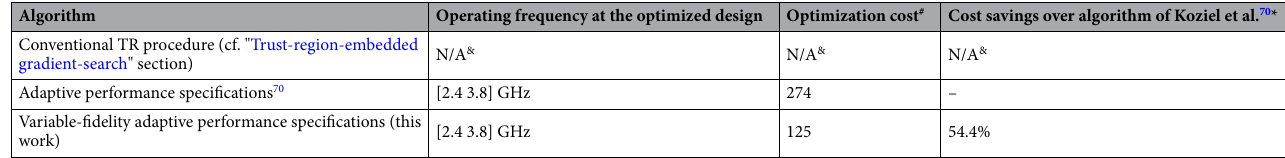
Table 5. Optimization results for Circuit III. $ Objective function computed as in (2). # Cost expresses in equivalent number of high-fidelity EM simulations. & The algorithm failed to identify a satisfactory design, in particular, align the circuit operating frequency with the target. *Relative computational savings in percent w.r.t. the algorithm of Koziel et al. 70 .